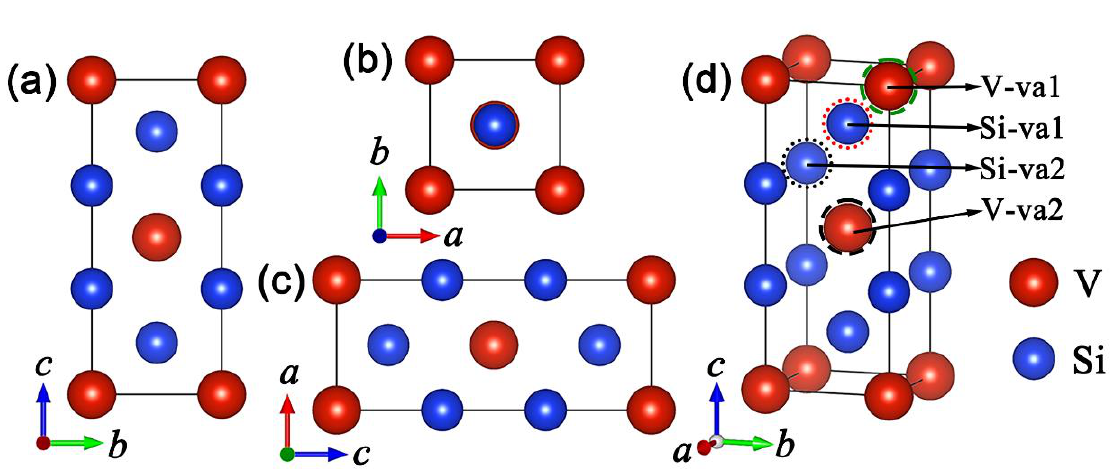
Figure 1. Crystal structure of C11 b -VSi 2 with different vacancies. ( a – c ): side views; ( d ): three-dimensional view.